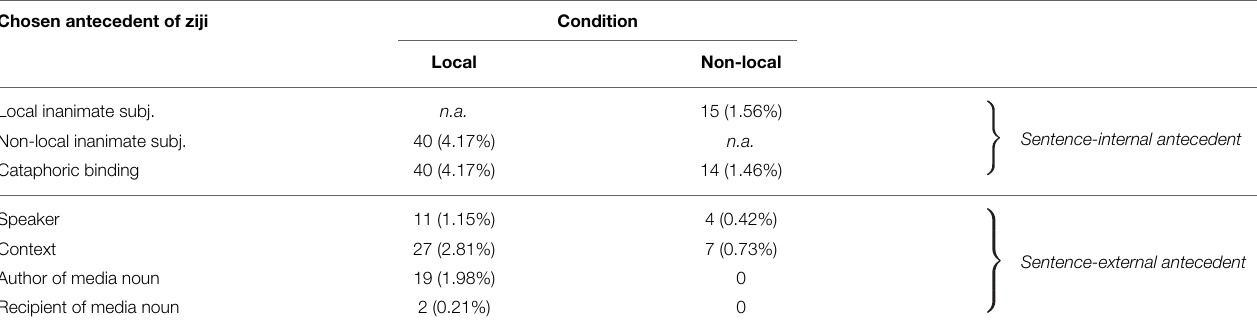
TABLE A1 | Pretest of Experiment 2: Classification of the participants’ answers in the “incorrect” trials by experimental condition. Chosen antecedent of